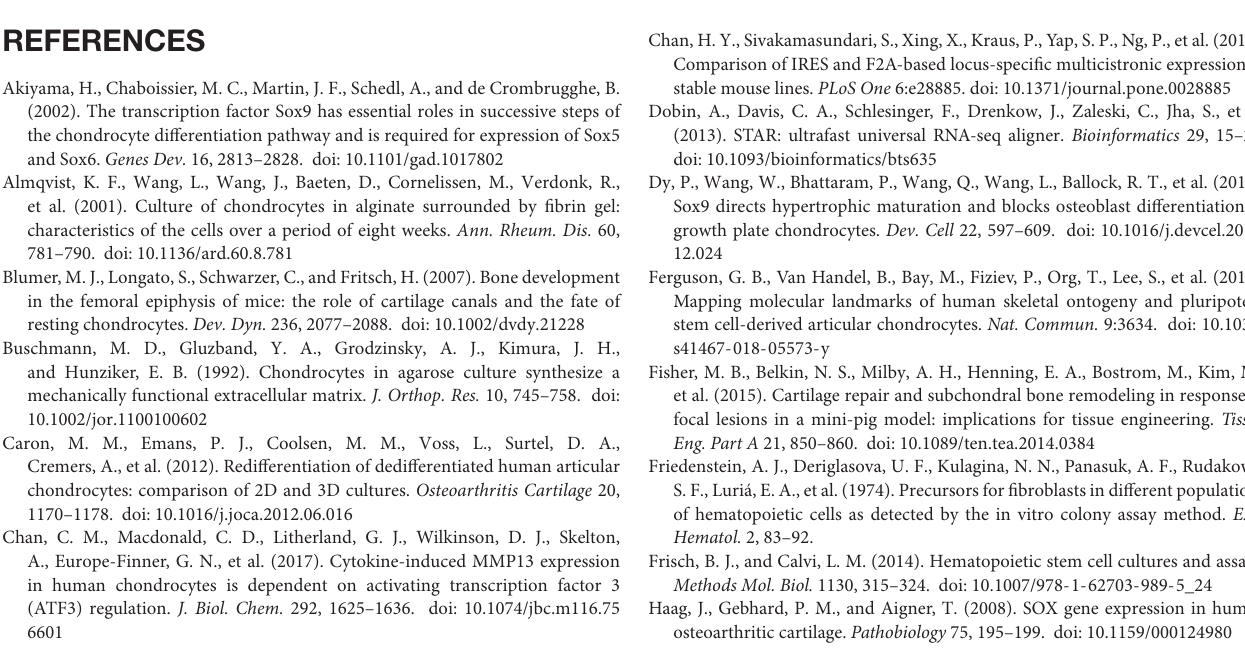
Supplementary Figure 1 | Supplemental characterization of Sox9GFP chondrospheres, femoral head, and knee joints. (A) Representative FACS analysis of dissociated Sox9GFP spheres after 8 weeks total culture. (B) Representative FACS plot of GFP expression in wild-type P7 femoral head cells (left) and